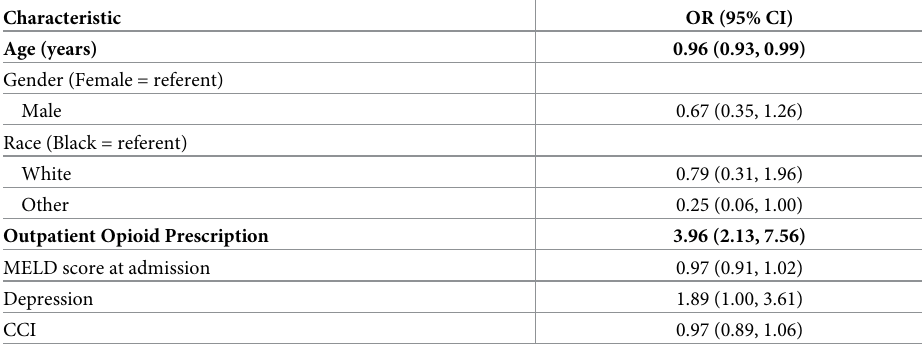
Table 4. Adjusted multivariable analysis of opioid